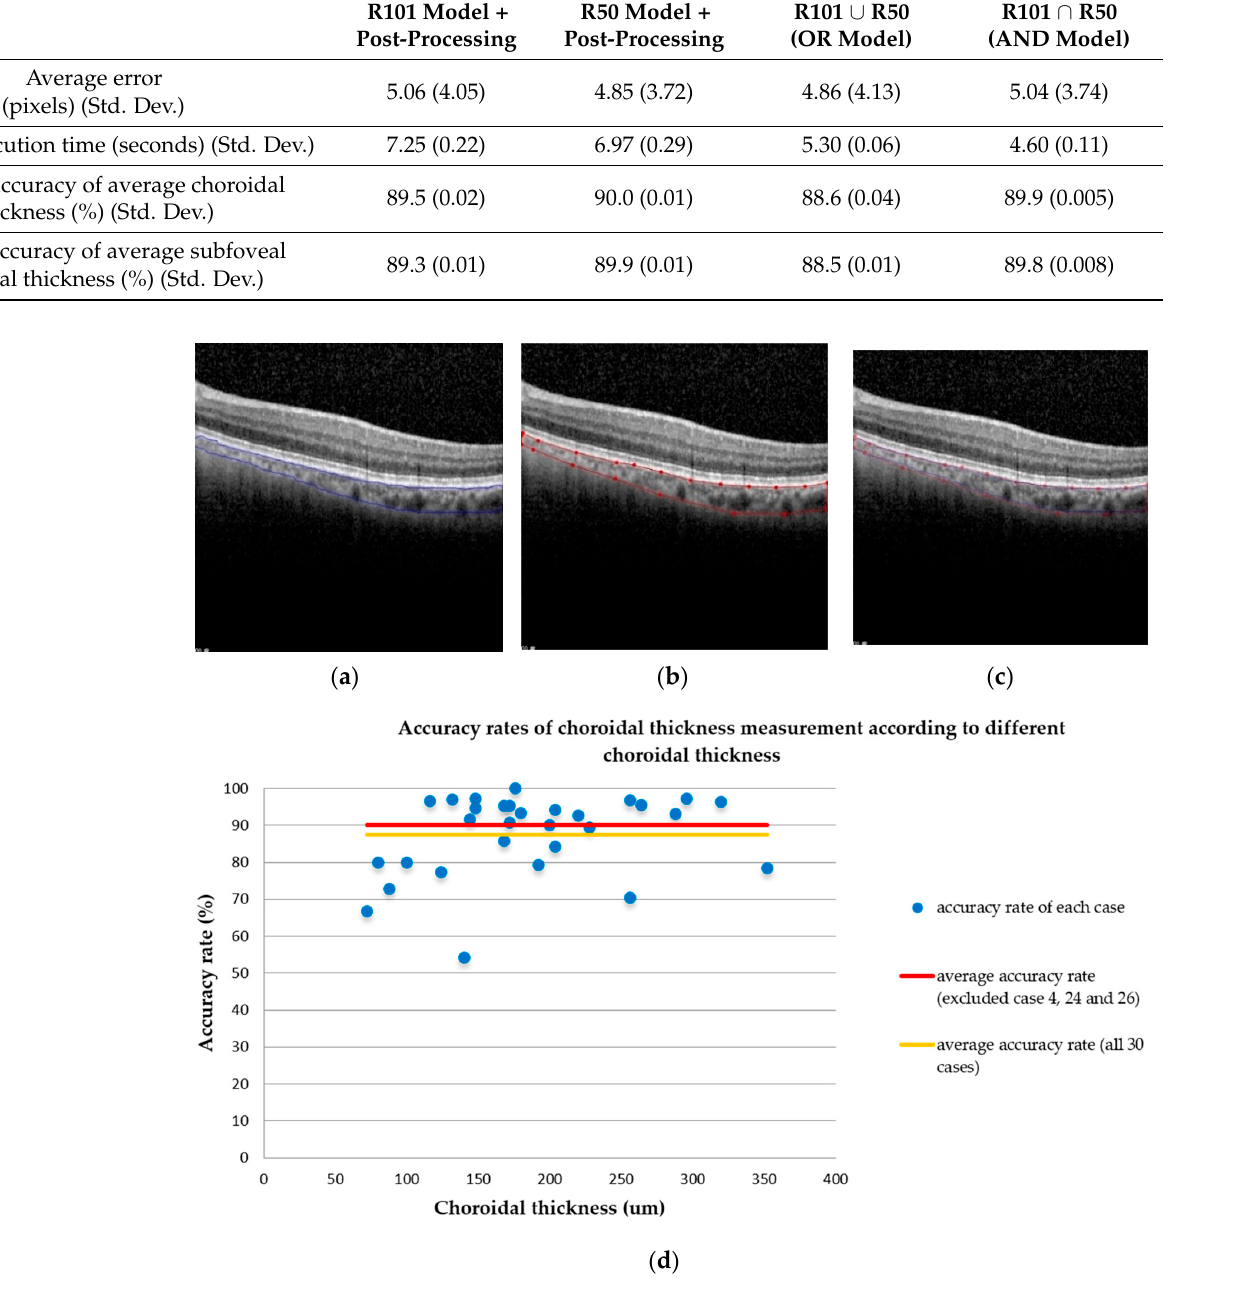
Figure 6. ( a ) Automatic sketching result; ( b ) doctor sketching result; ( c ) combination of Figure 6a,b for comparison of sketching contour by the proposed model and physicians; ( d ) the blue spots show accuracy rates of each case with different choroidal thicknesses. The yellow line shows the average accuracy rate of all 30 cases with the value of 87.5%. The red line shows the average accuracy rate of residual 27 cases with the value of 90.2%, after excluding three cases (case 4, case 24 and case 26) with relative lower accuracy rate due to various influence factors.